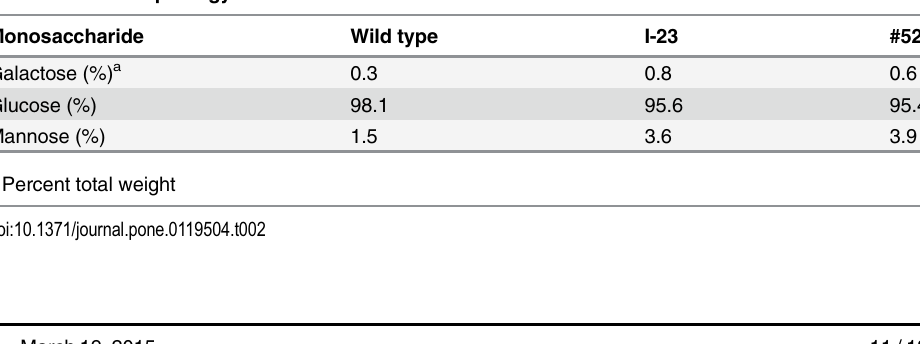
Table 2. Monosaccharides released from acid-treated cellulose pellicles produced by wild type and two cellulose morphology